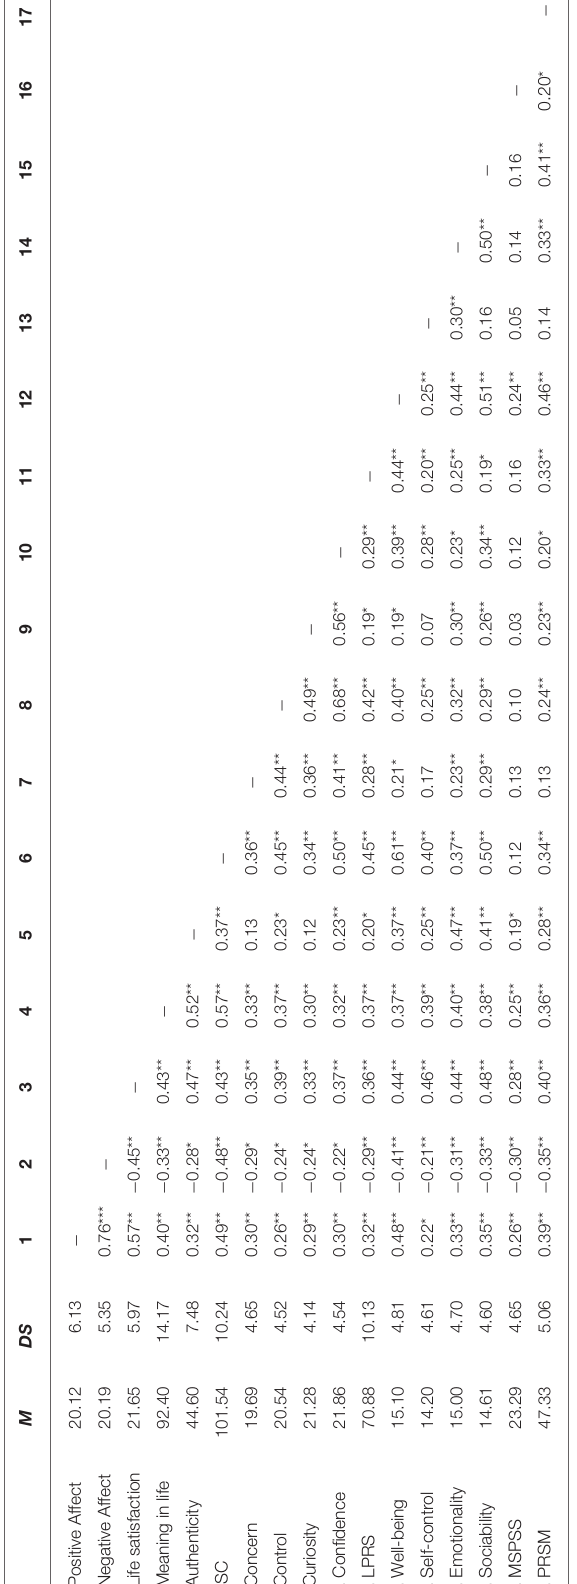
TABLE 2 | Fit indices and fit changes for model 1 trough model